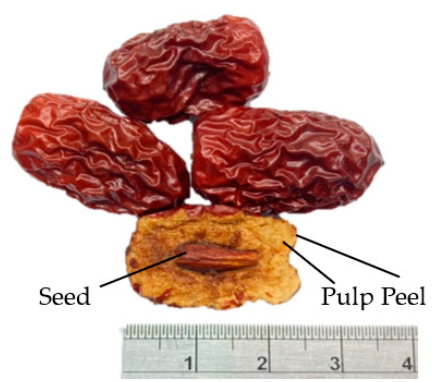
Figure 1. Jujube fruit and its seed and peel pulp.